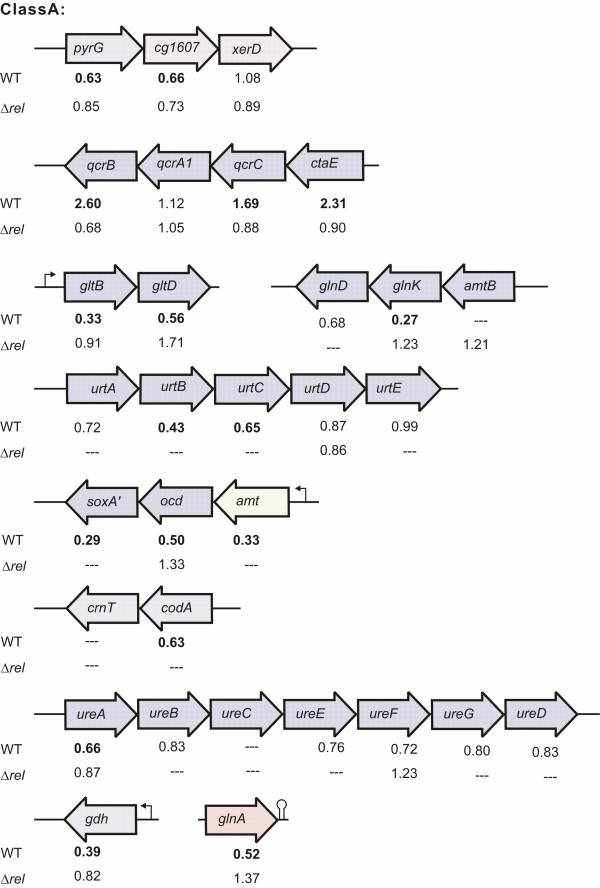
Graphical representation of selected genes and putative operons comprising genes of classe A in their genomic organization. Below each gene, the induction or repression ratios are given for both strains, C. glutamicum RES167 and its derived Δrel mutant. Bold numbers indicate a significant induction or repression of the corresponding gene according to the filtering criteria (5% error probability) applied on the microarray data. Genes are not drawn to scale. Known transcription start points are marked by small arrows. Predicted rho-independent terminators are indicted by hairpins.